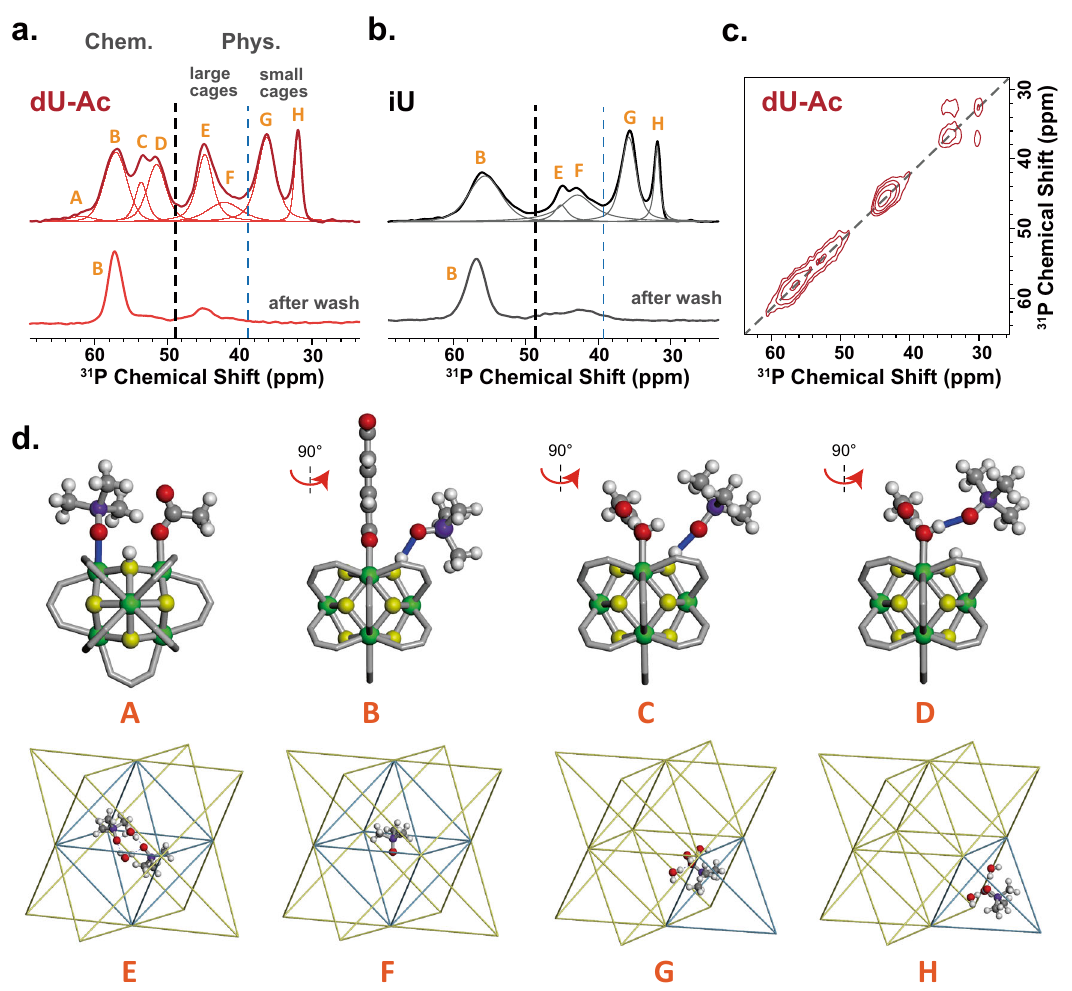
Fig. 3 | Adsorption of TMPO. 1 H- 31 P CP spectra of TMPO loaded in a dU-Ac (defective UiO-66 with acetate) and b iU (ideal UiO-66). The lower spectra are collected after washing with dichloromethane. The bold dotted lines separate the chemical shifts for physical and chemical adsorptions. The thin dotted lines sepa- ratethechemicalshiftsforphysicaladsorptionsinlargeandsmallcages.Theletters